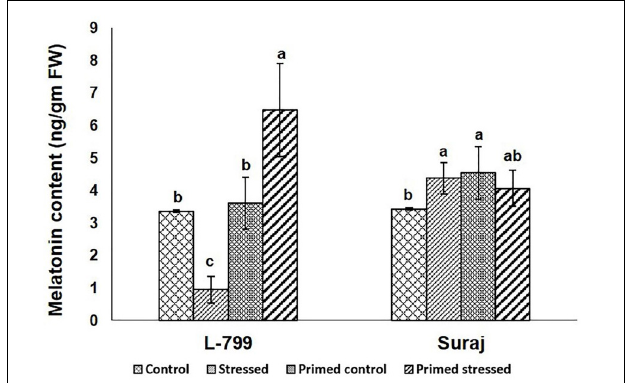
FIGURE 4 | Effect of melatonin priming on endogenous melatonin content in drought-tolerant and -sensitive varieties with or without drought stress. Data represent mean values ± SD of 3 independent experiments. Different alphabets within the group represent significant differences among treatments according to Duncan multiple range test at P <